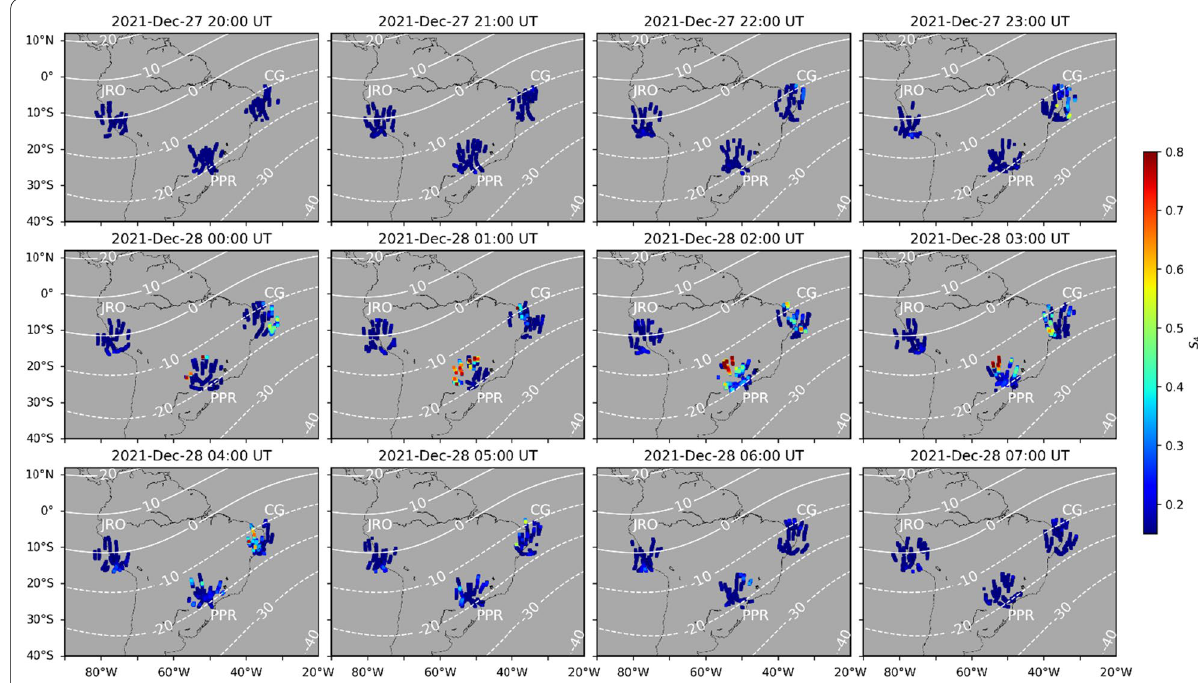
Fig. 10 Snapshots of L1 S 4 measurements as a function of ionospheric piercing point (IPP) coordinates for measurements made by ScintPi 3.0 sensors at the Jicamarca Radio Observatory (JRO), Campina Grande (CG), and Presidente Prudente (PPR). The time on top of each panel indicates the end time of the 1 h intervals under which measurements were made. Only measurements from satellites with elevation greater than 30° are